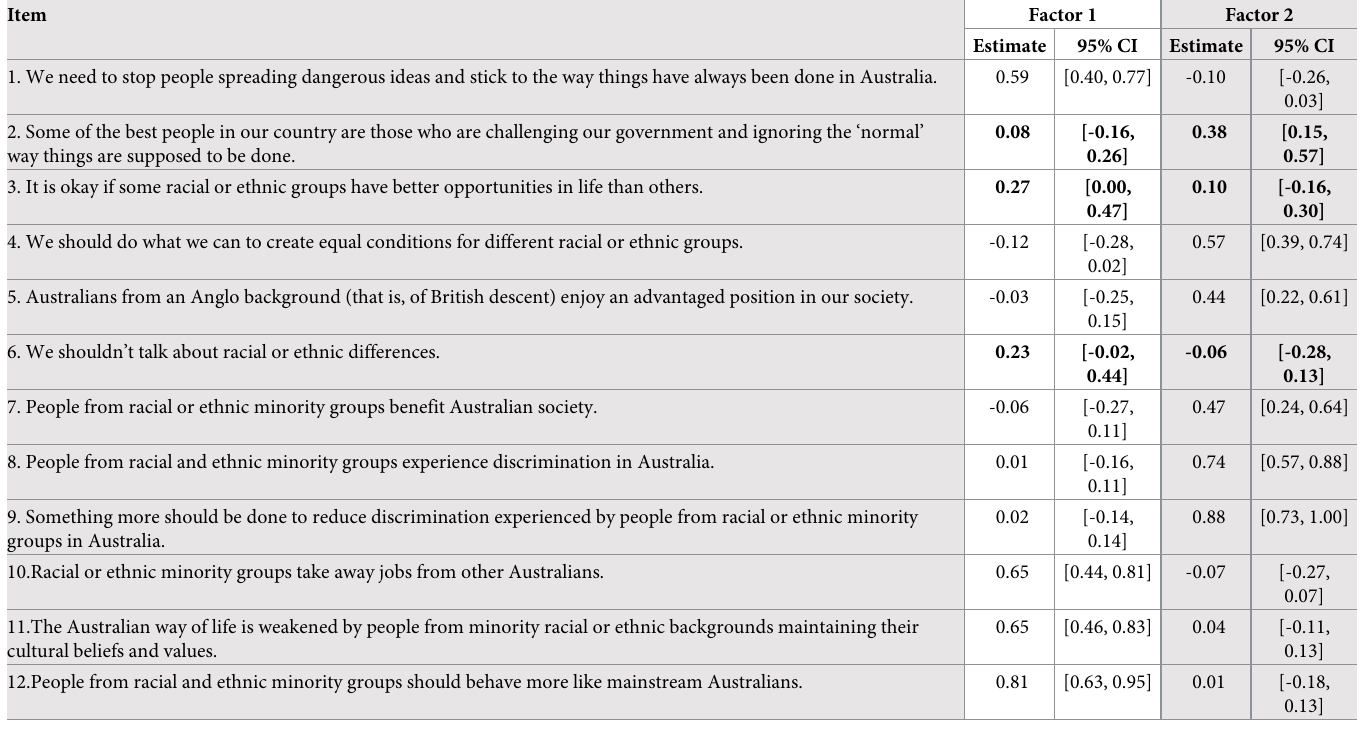
Table 2. Exploratory Factor Analysis: Factor loadings ( λ s) and bootstrapped 95% CI (n = 271).